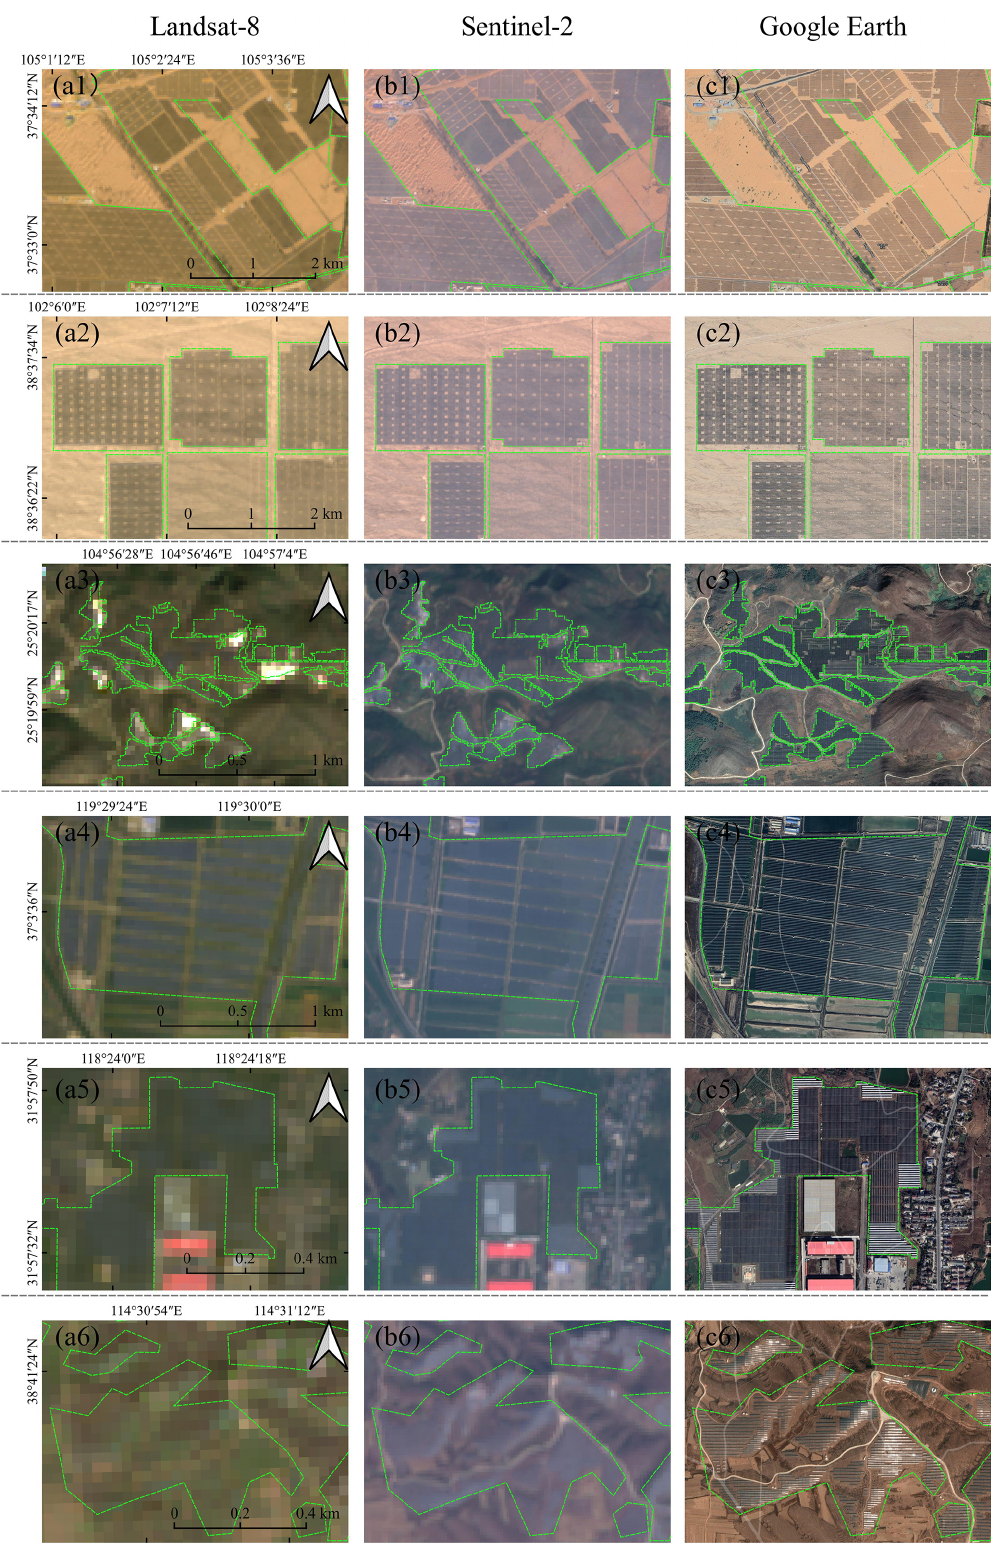
Figure 2. The visual interpretation examples (six sites) from (a) Landsat 8, (b) Sentinel-2, and (c) Google Earth RGB true color images. The green dashed line is the boundary of the PV panels. © Google Earth 2021.